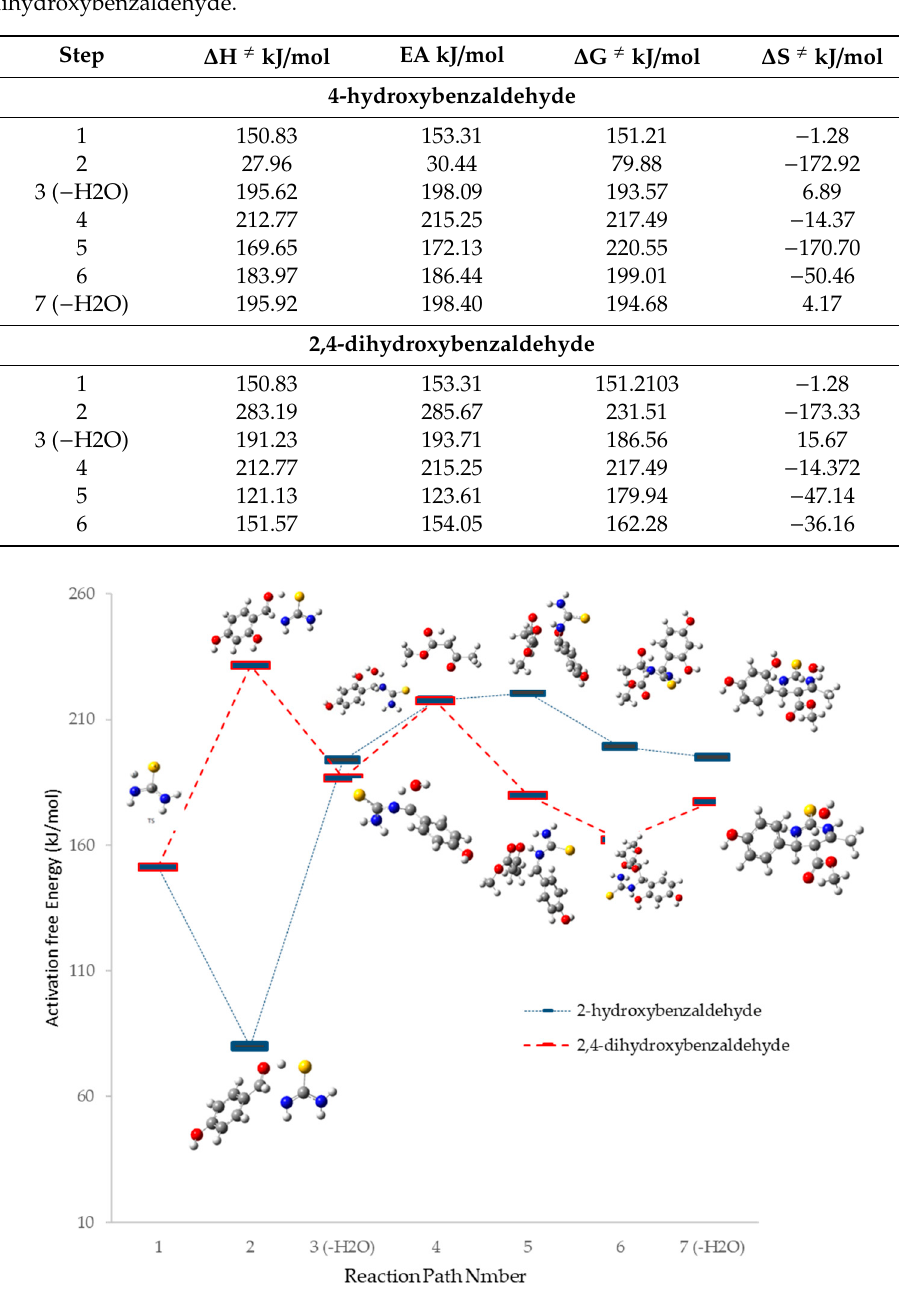
Scheme 1. Reaction energy diagram for Biginelli adduct’s formation from 2-Hydroxybenzaldehide and 2,4-dihidroxybenzaldehide at B3LYP/6-31++G(2d,p).